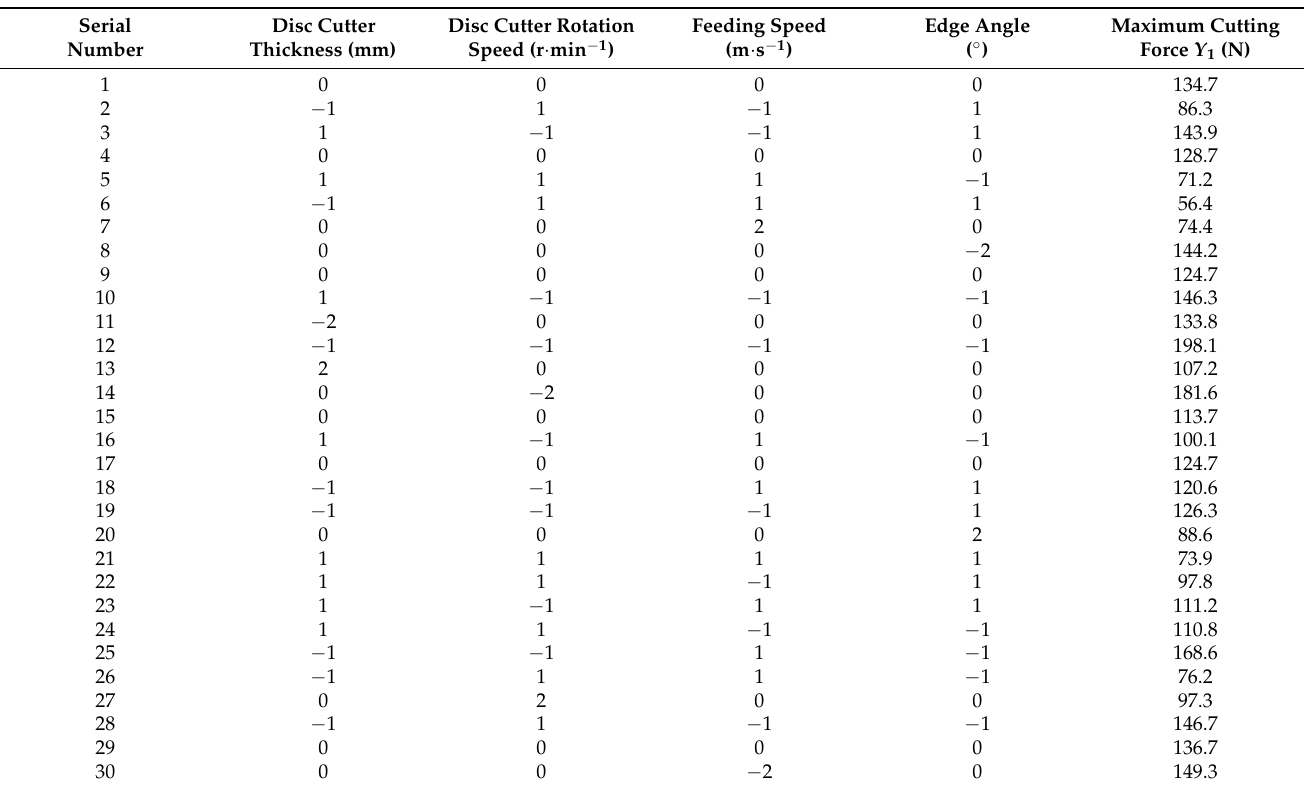
Table 4. Test schemes and results.